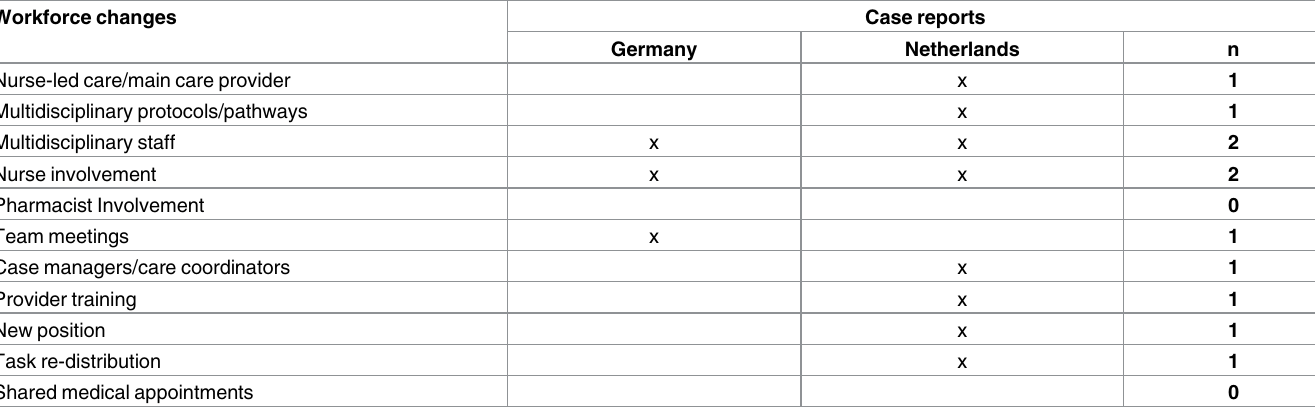
Table 6. Overview of workforce changes per case report and number of case reports mentioning the respective changes. Workforce